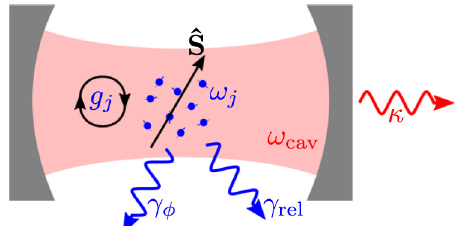
FIG. 7. The collective decay described by Eqs. (3) and (21) can be implemented experimentally by coupling N spin-1 / 2 sys- tems (level splittings ω j ) to a strongly damped bosonic mode (frequency ω cav and single-spin coupling strengths g j ). The mode is depicted here as a resonant mode of a photonic cavity but we could use a wide variety of systems (e.g., microwave or mechan- ical modes). The energy decay rate of the bosonic mode is κ and each spin may undergo local relaxation or dephasing processes at rates γ rel or γ φ , respectively.